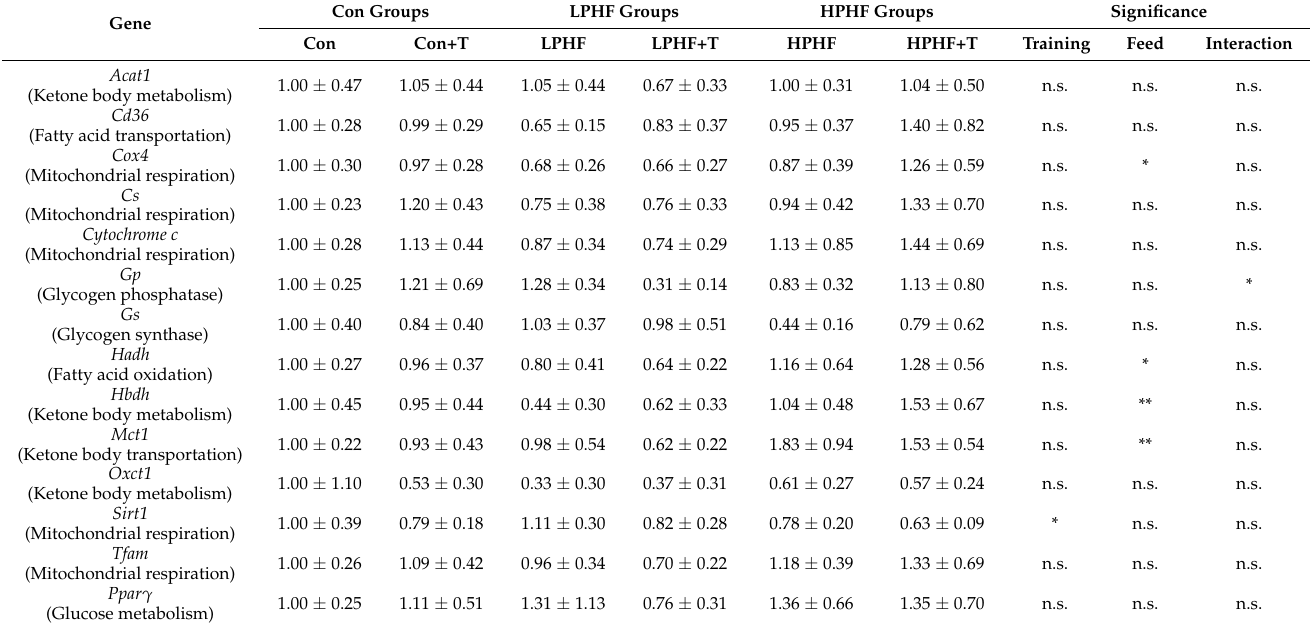
Table 7. Effects of LPHF, HPHF, and/or training on gastrocnemius muscle gene